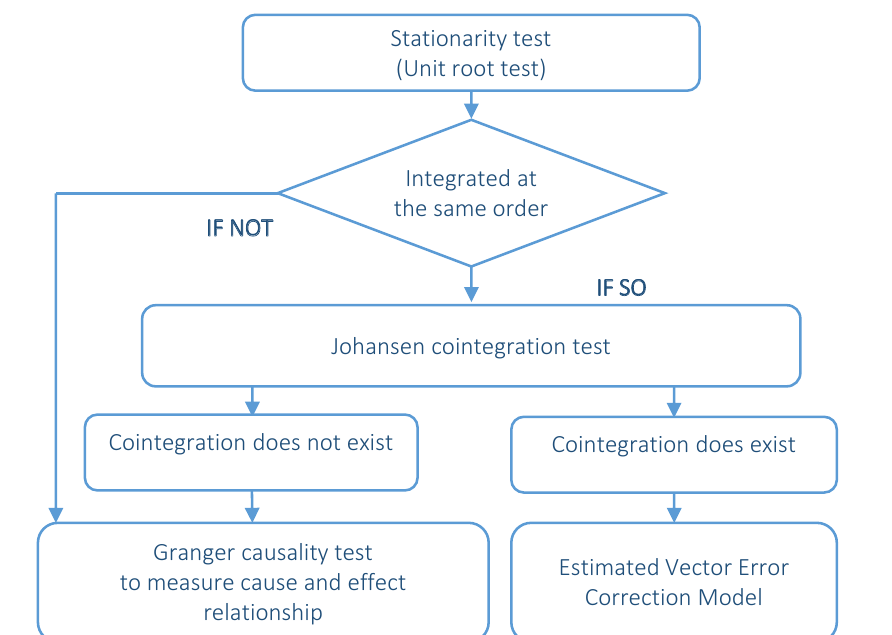
Figure 1. Implementation procedure of data